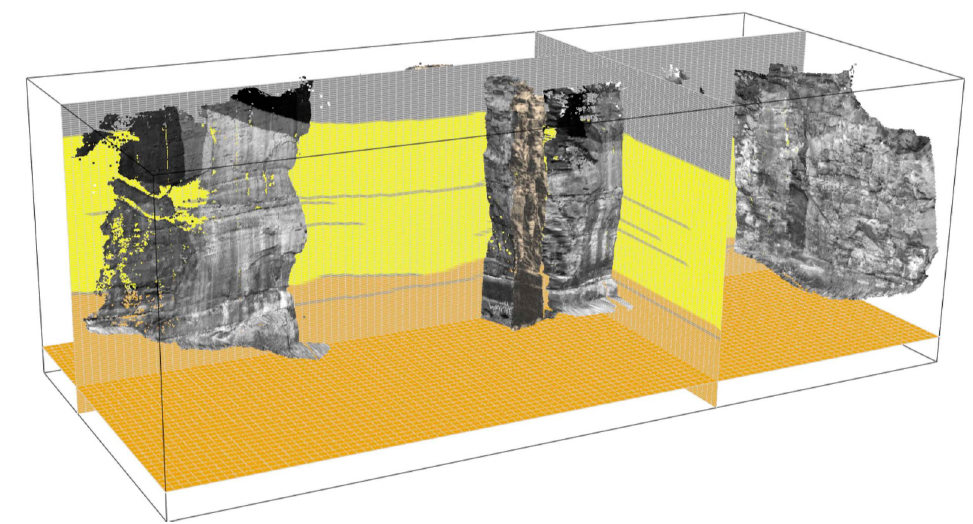
Figure 21. 3D attributed S-Grid generated from VOM.